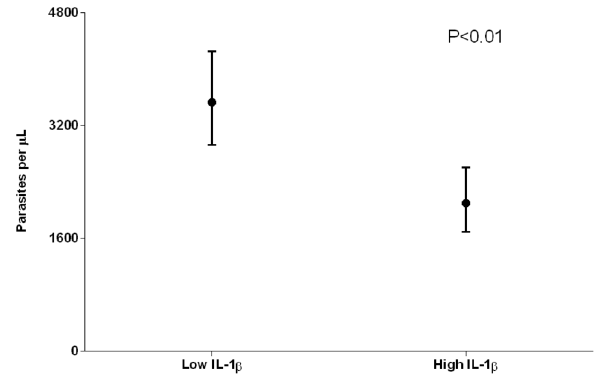
Figure 1. Average parasite densities in children with high and low cord IL-1β levels. Only infections occurring in the first year of life were included in this analysis, since the association between levels of this cytokine at birth and subsequent parasite levels was only present during infancy (GEE model). (N=504, children with at least one infection during infancy) Concentrations of parasites per μL were estimated by assuming 8000 leukocytes/μL of blood. Children were defined as having high cord IL-1β levels if their IL-1β levels at birth were higher than the median in the study population (6 pg/ml); if IL-1β levels at birth were lower than the median value, these levels were considered low.